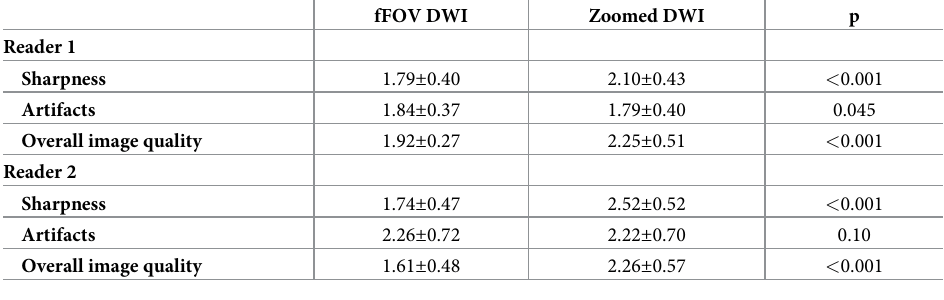
Table 2. Assessment of the image